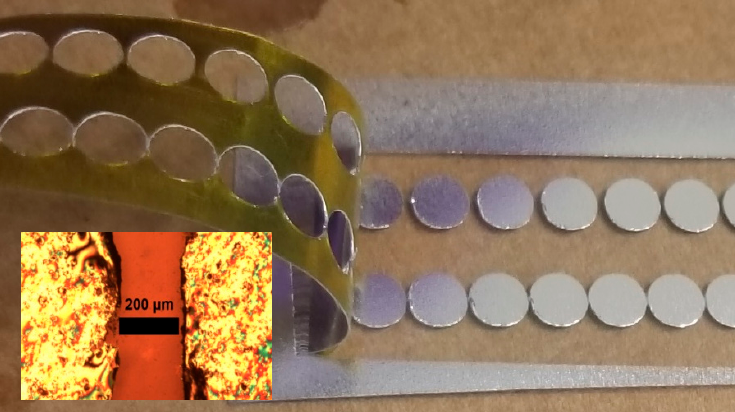
Figure 2. Spray-on Liquid-Metal electrode stencil removal process step. Inset: Magnified view of a liquid-metal electrode pair with a channel width of 200 μ m.